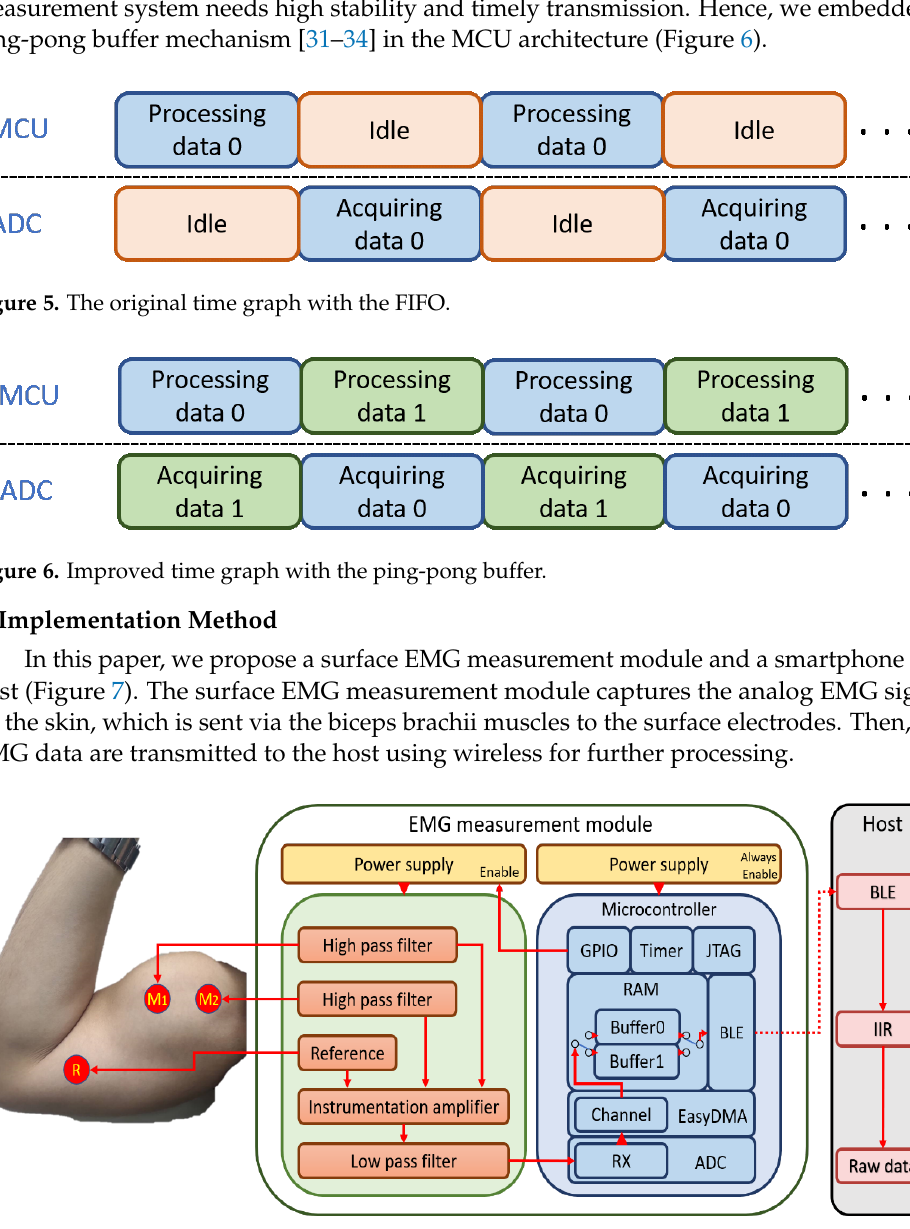
Figure 7. Diagram of the proposed surface EMG measurement module system.